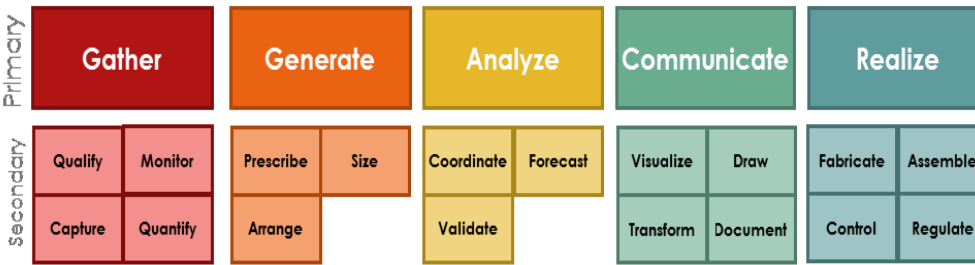
Fig. 2. The BIM uses and purposes: the primary and secondary uses of BIM (Kreider & Messner, 2013, p.